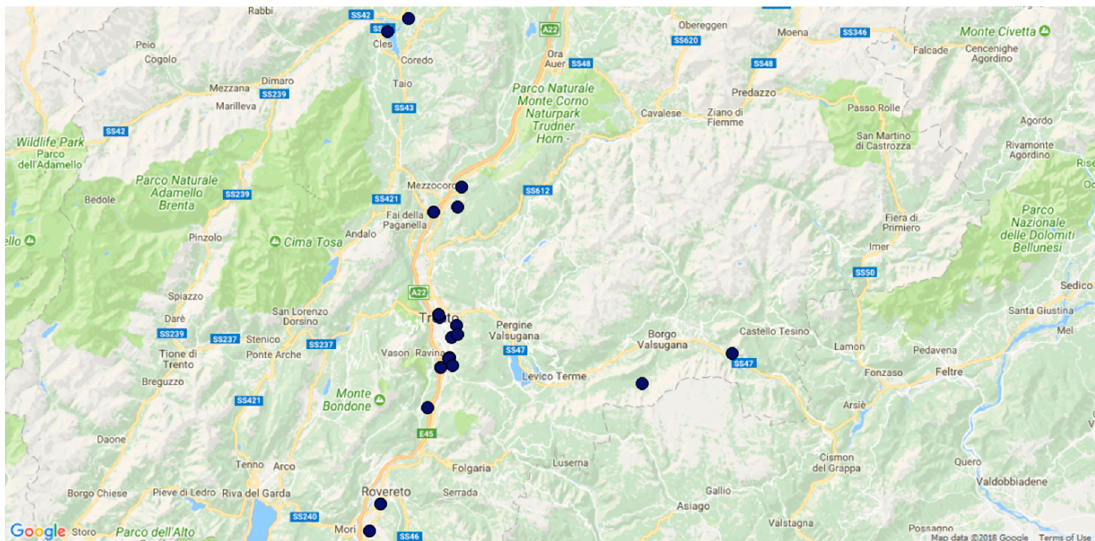
Figure 1. An Open Street Map of the area monitored by pheromone traps, with dark-blue dots representing the coordinates of the traps placed in orchards, field crops, public parks, outdoor parking spaces, bushes and anthropogenic settings. Table 1. List of the environmental GIS layers included in the